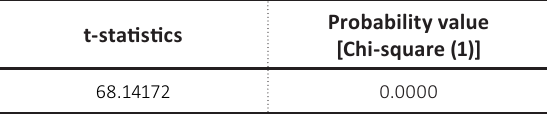
Table 2. ARCH LM test results